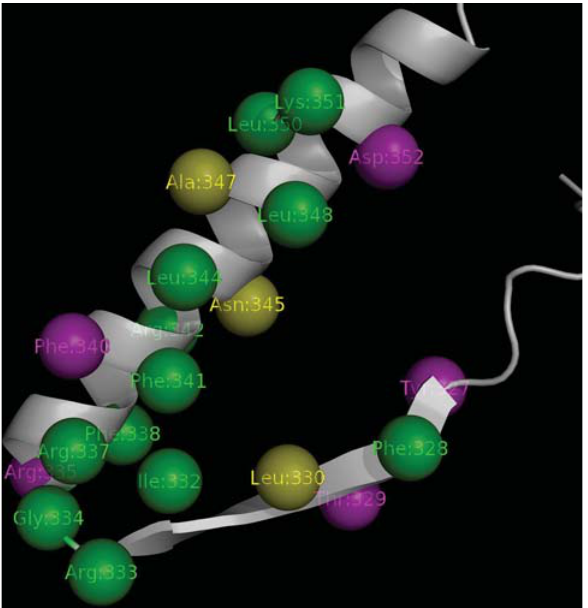
Figure 2 - One monomer from the tetramerization domain of the p53 tu- mor repressor (3sak:A). True positives are indicated in green, false posi- tives in purple and false negatives in yellow.